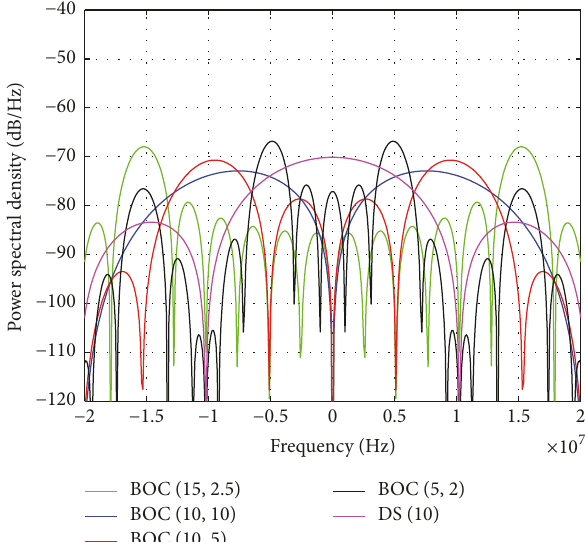
Figure 1: Power spectral density of the BOC